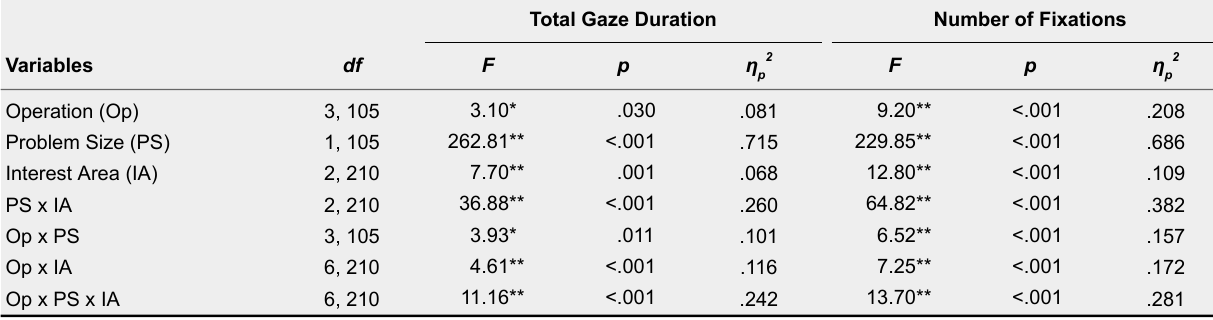
Statistical Analyses of the Number of Fixations and Total Gaze Duration